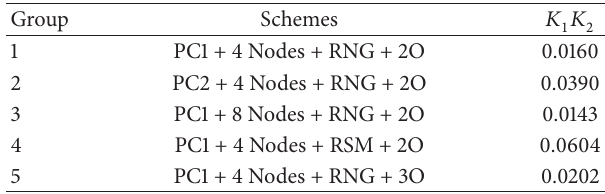
Table 8: Various schemes under